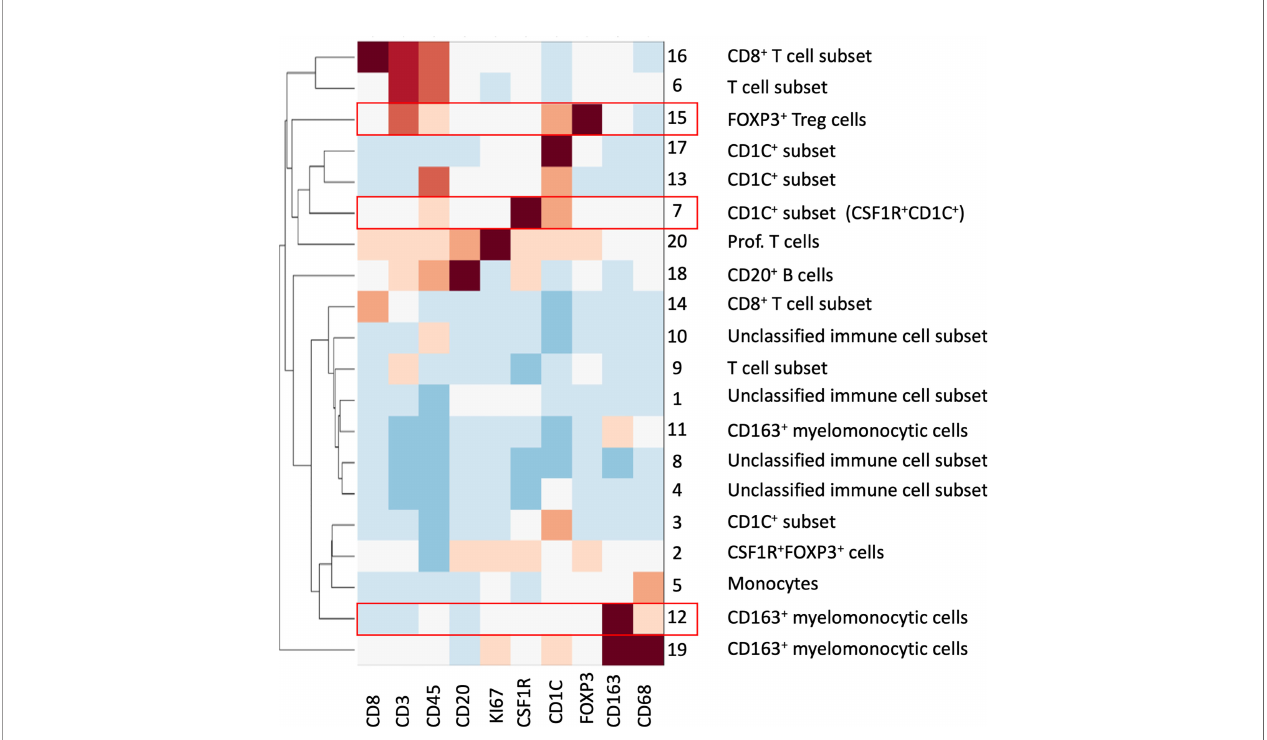
FIGURE 6 | SSC of all immune cells from all ROIs based on the 10 mIHC markers. A total of 20 cell groups were interpreted based on their expression of mIHC markers. Cell groups with statistical signi fi cance were highlighted in red; please see also Figure 7 .